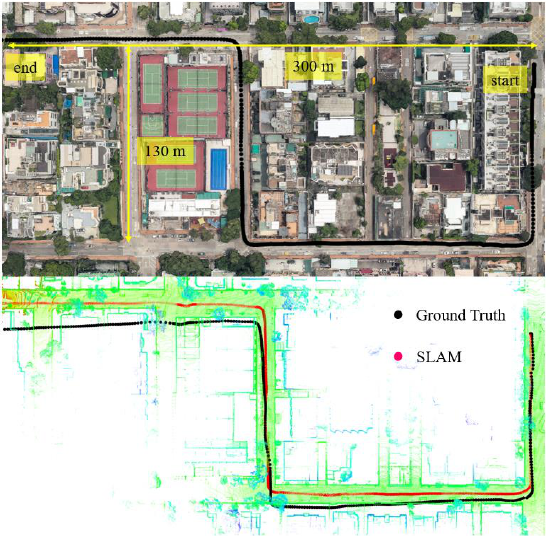
Figure 8. Experiment 2: the trajectory of NDT-based graph SLAM in a sparse area with dense traffic condition. Top panel represents the snapshot in Google Maps. The black curve indicates the ground truth of the vehicle’s trajectory. The bottom panel indicates the generated points map and trajectory from SLAM. 362